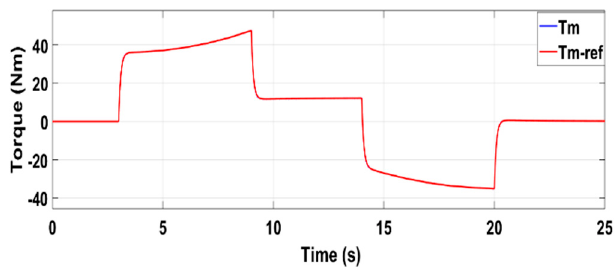
Figure 12. Motor torque and reference with EQZSI.